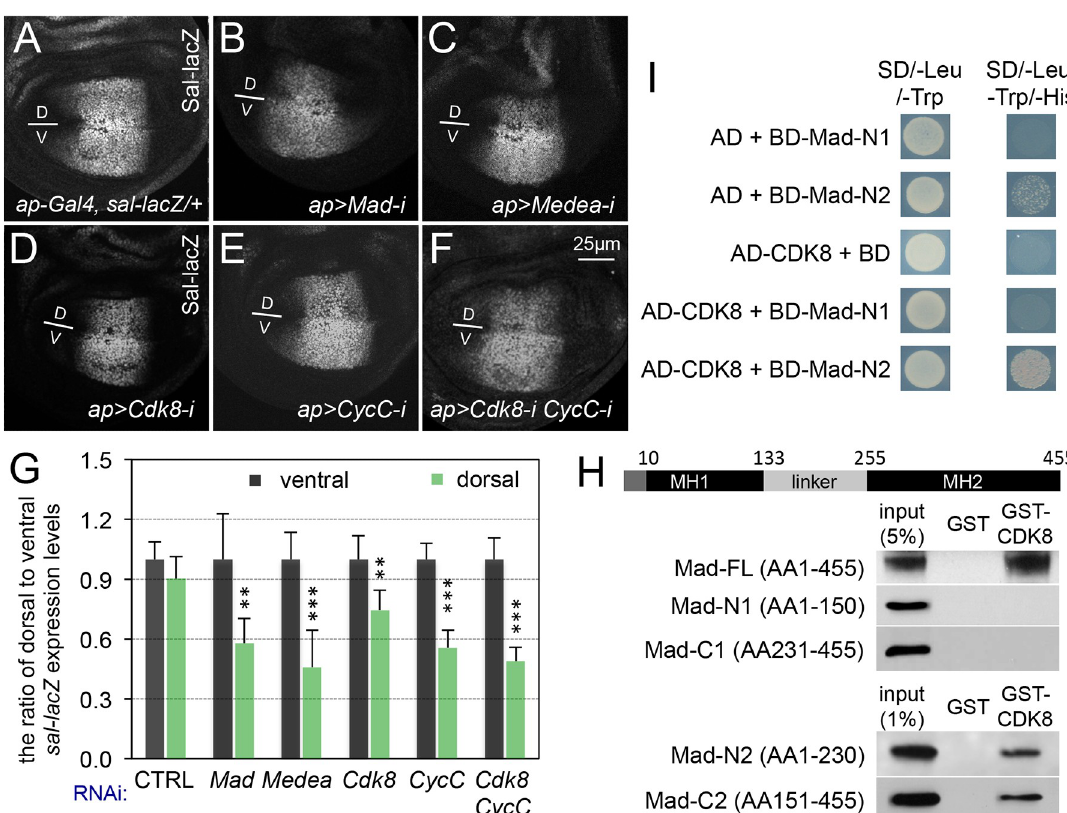
Fig 5. CDK8-CycC positively regulates Mad-dependent transcription. Confocal images of the wing pouch area of a L3 wandering larval wing disc of (A) ap-Gal4 , sal-lacZ/+ (control); (B) ap-Gal4 , sal-lacZ/UAS-Mad-RNAi (BL-43183); (C) ap-Gal4 , sal-lacZ/ UAS-Medea-RNAi ; (D) ap-Gal4 , sal-lacZ/+; UAS-Cdk8-RNAi/+ ; (E) ap-Gal4 , sal-lacZ/+; UAS-CycC-RNAi/+ ; and (F) ap-Gal4 , sal-lacZ/ +; UAS-Cdk8-RNAi CycC-RNAi/+ . All signals presented were from anti- β -galactosidase staining. Scale bar in F: 25 μ m. Dorsal (D)- ventral (V) boundaries are marked using a short line in these images. (G) Quantification of Sal-lacZ expression. The black columns represent the average of Sal-lacZ expression in the ventral compartment of the indicated genotypes (N = 5 for each genotype), and light green columns represent the measurements in the dorsal compartments. (H) Western Blots of a GST pull-down assay between GST-CDK8 and His-tagged Mad fragments. The amino acids (AA) positions of MH1 and MH2, separated by the linker region, are based on a BLAST search of Drosophila Mad-RA isoform (455AA). The other isoform, Mad-RB (525AA), has additional 70AA at the N- terminus. We focused on the Mad-RA isoform in this work. (I) Y2H assay showing the specific interaction between CDK8 and the linker region of Mad. SD/-Leu/-Trp and SD/-Leu/-Trp/-His are synthetic dropout (SD) media lacking “Leu and Trp”, or “Leu, Trp, and His”, respectively. The co-transformed yeast cultures were spotted on SD/-Leu/-Trp and SD/-Leu/-Trp/-His plates, positive interactions result in yeast growth on the SD/-Leu/-Trp/-His plate. AD, GAL4-activation domain (prey); BD, GAL4-DNA-binding domain (bait); AD- or BD-protein, AD- or BD-fusion proteins.